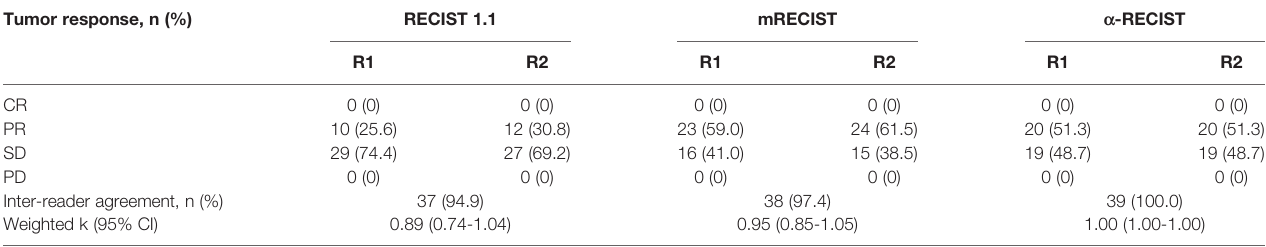
TABLE 4 | Response rates according to evaluation criteria for two independent radiologists with inter-reader agreement ( n =39). Tumor response, n (%)